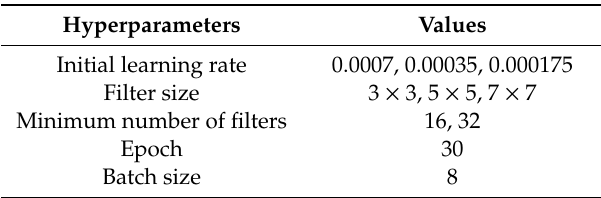
Table 2. Neural network